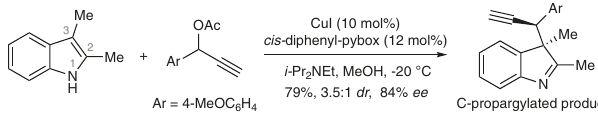
Fig. 1 Cu-catalyzed asymmetric propargylation of 2,3-dimethyl indole. C-propargylated product was exclusively